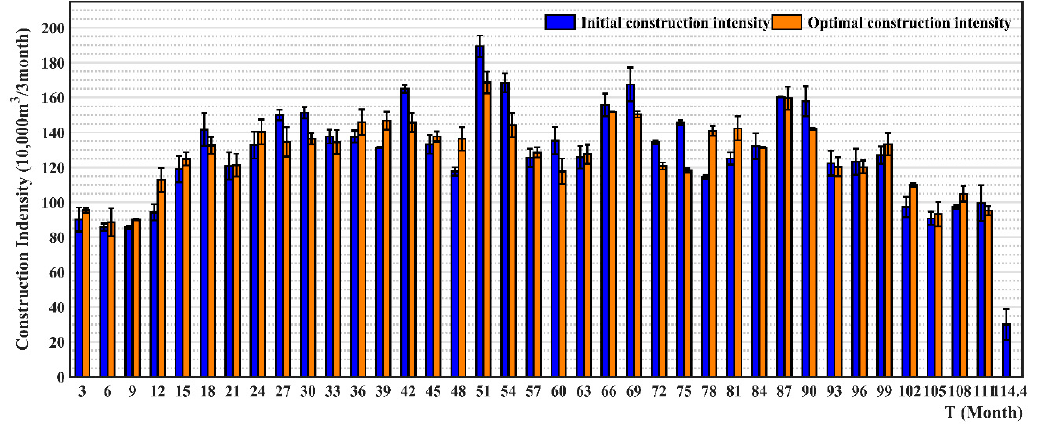
Figure 15. Monthly filling intensity comparison of the optimal and initial plans.